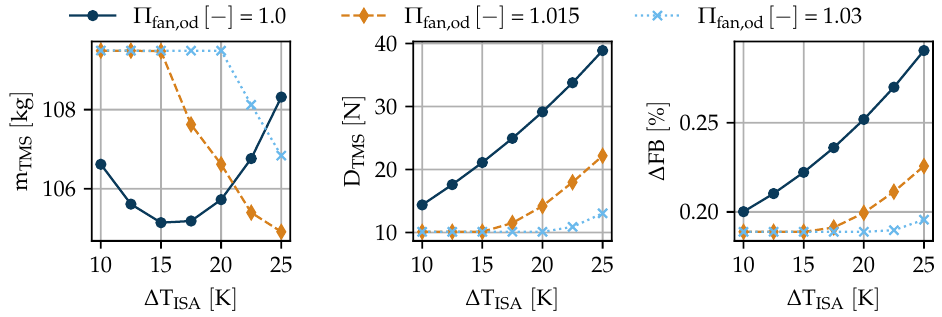
Figure 12. Multi-point optimization for a TMS for T cp , des = 380 K and S P = 30%. Three different off-design fan pressure ratios ( Π fan , od ) were investigated. If Π fan , od is 1.0, no fan installation is required. For the larger values of Π fan , od , all results form horizontal lines for lower ∆ T ISA . This implies that the optimal design is only dependent on the design point, and the additional off-design constraint is met because Π fan , od is oversized. Only when ∆ T ISA increases beyond a certain threshold, the off-design constraint becomes